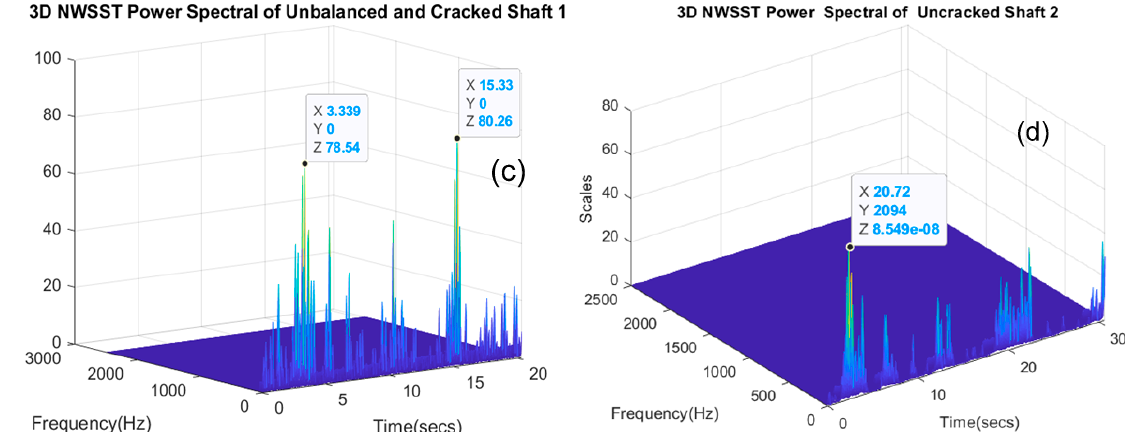
Figure 13. 3D experimental NWSST of ( a ) cracked unbalanced driveshaft, ( b ) unbalanced driven shaft.